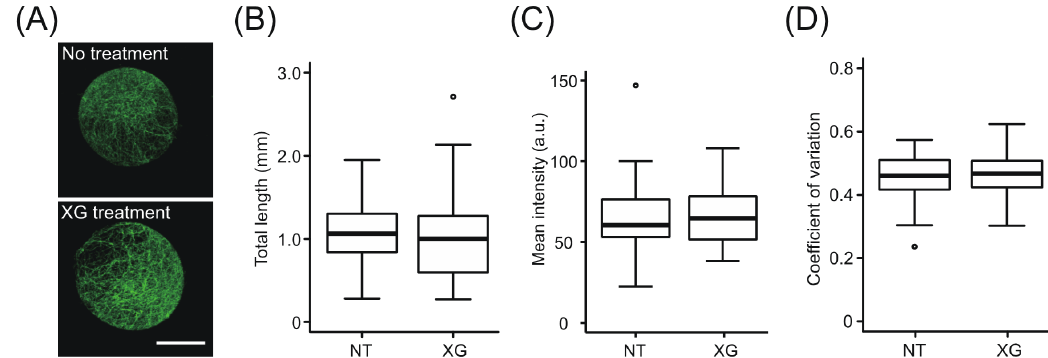
Figure 4. Immunofluorescent labeling of crystalline cellulose on the surface of xxt1 xxt2 protoplasts. ( A ) Representative images of crystalline cellulose network regenerated from xxt1 xxt2 protoplasts incubated in the regeneration medium lacking xyloglucan (NT) or containing xyloglucan (XG) for 24 h. Protoplasts were examined by immunocytochemistry using CBM3a antibody, which specifically recognizes crystalline cellulose. ( B – D ) Total length ( B ), mean intensity ( C ), and CV of fluorescence intensity distribution ( D ) of CBM3a-labeled network on protoplast surface. Center lines of box-plot show the medians, boxes indicate interquartile range (IQR), whiskers indicate 1.5 IQR, and outliers are shown by dots. Significance (vs. NT) was determined by Mann–Whitney test ( p < 0.05; n = 49 (NT) and 50 (XG)). Scale bar = 20 μ m.